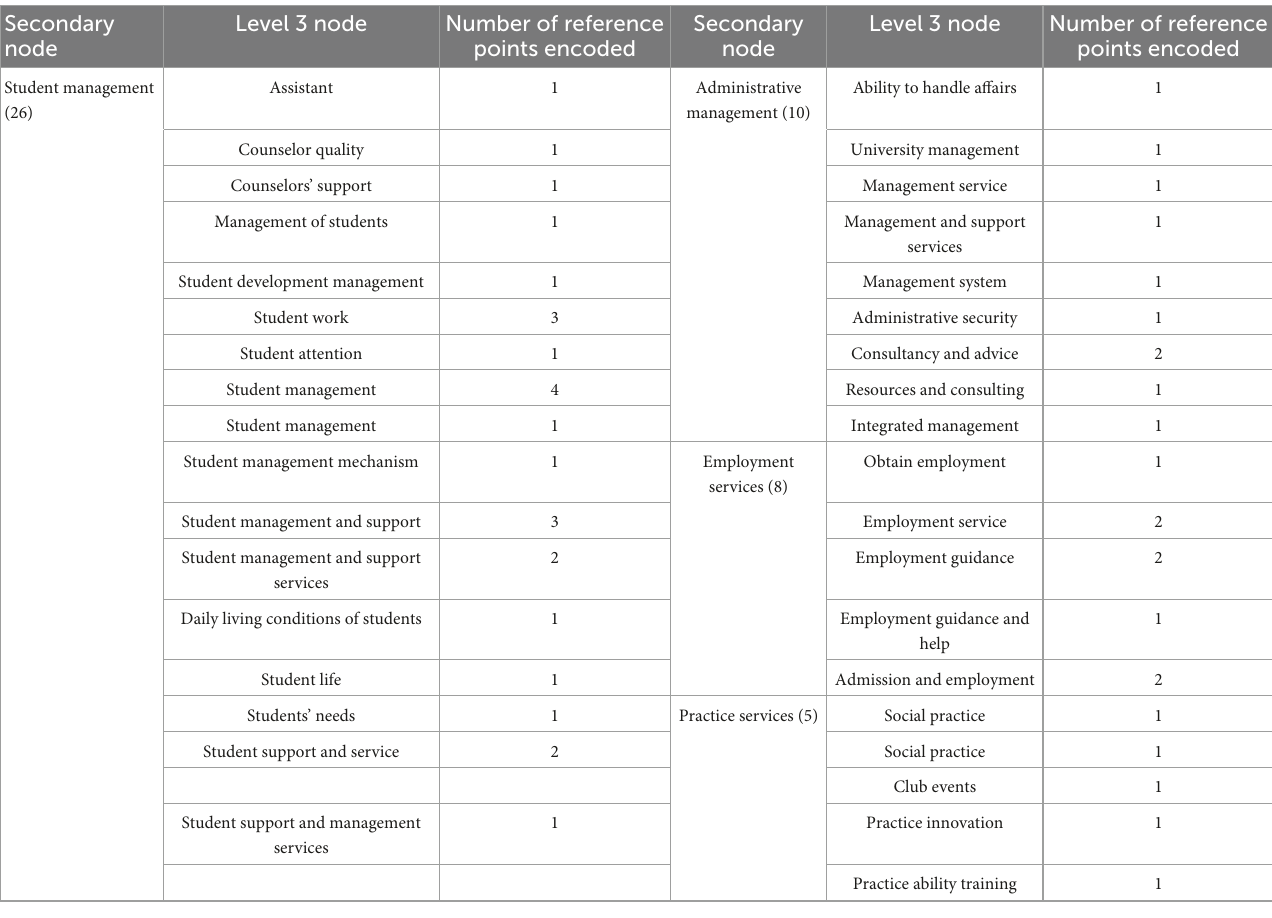
TABLE 5 Nodes and coding reference points in logistical support. Secondary